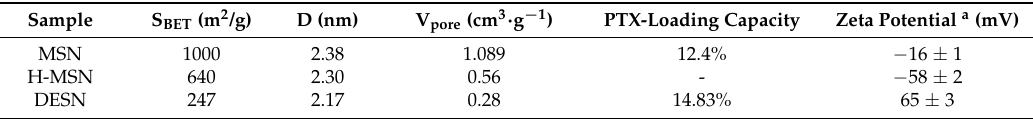
Table 1. Structure parameters, PTX-loading efficiency, and zeta potential of the fabricated samples (MSN, H-MSN, and DESN).